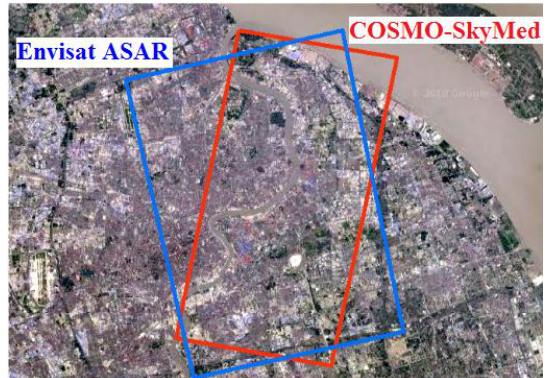
Figure 2. Experimental data coverage (satellite image from Google)